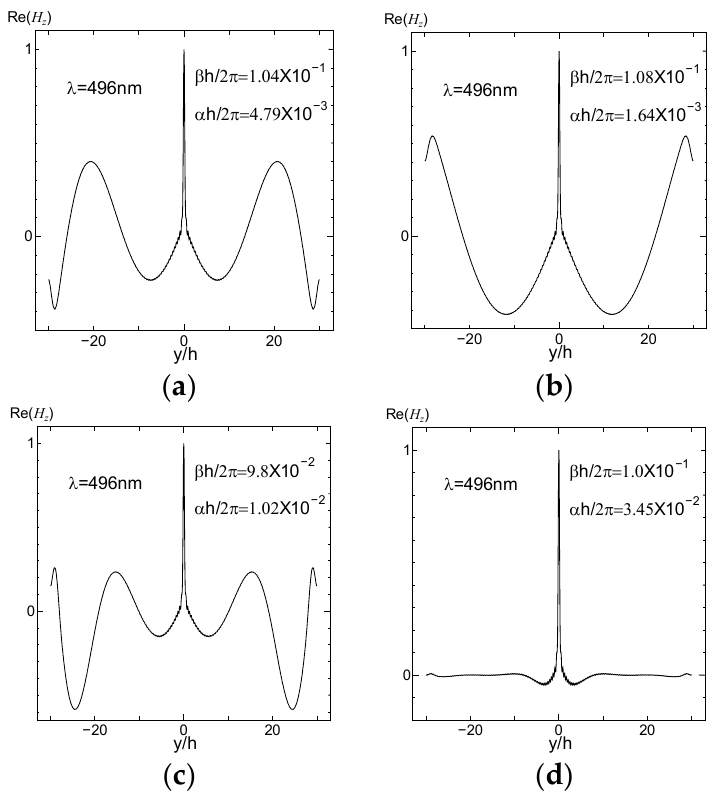
Figure 4. Distribution of the Hz field as a function of the y coordinate representing the wavelength of 496 nm. ( a ) Even mode 1; ( b ) even mode 2; ( c ) even mode 3; ( d ) even mode 4.